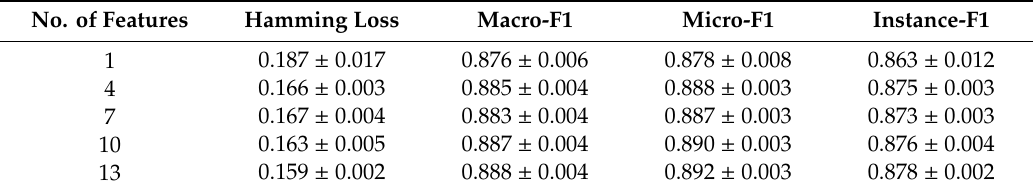
Table 4. Experimental results of KQI prediction with feature-weighted ML-kNN ( k = 15, L = 14) and